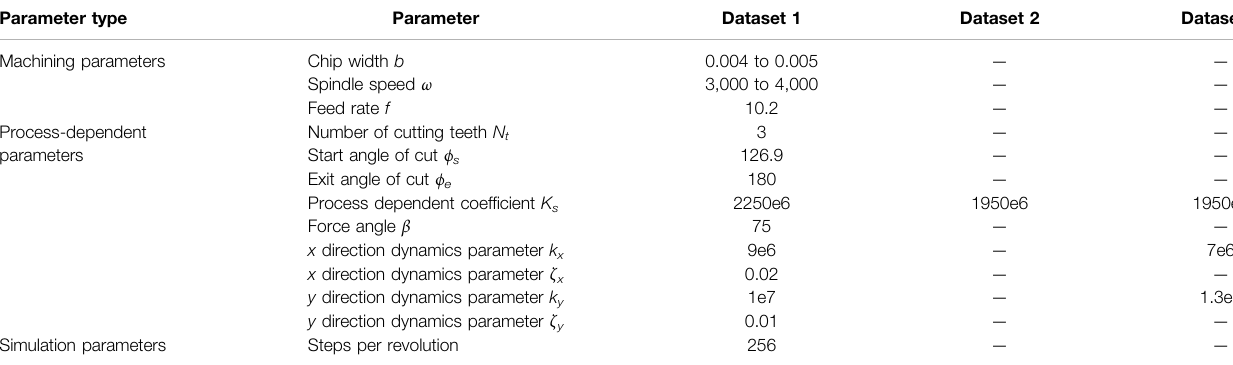
TABLE 1 | Milling time-domain simulation